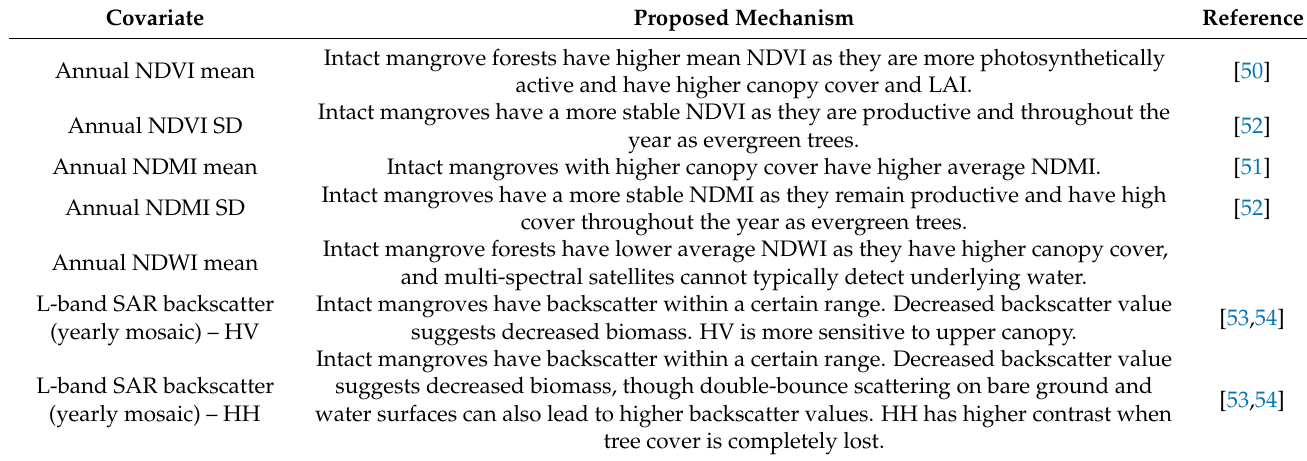
Table 2. Satellite-derived covariates used to model mangrove degradation. The table suggests the expected mechanism for detecting mangrove degradation. Covariate Proposed Mechanism Reference Annual NDVI